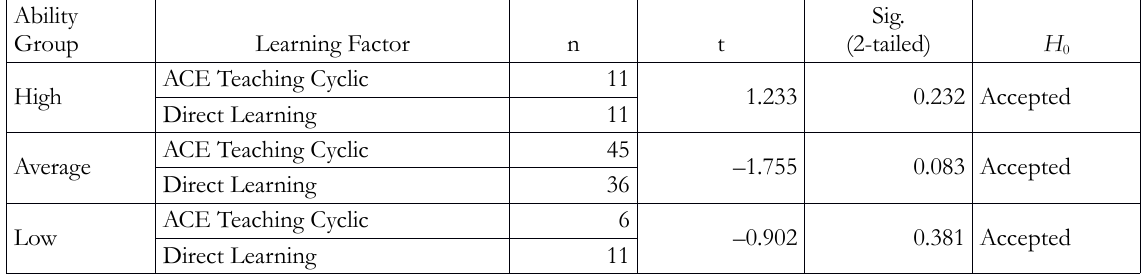
Table 5. The Difference Test Result of N-Gain Data of